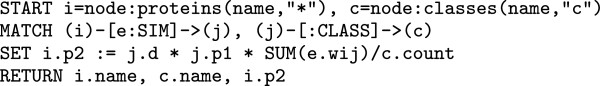
Neo4j Implementation of 1-step RW algorithm in cypher. The notation (i)-[e:rtype]->(j) is used to represent a relationship e of type rtype between nodes i and j. The dot-notation is used to access a single property of a node/edge.